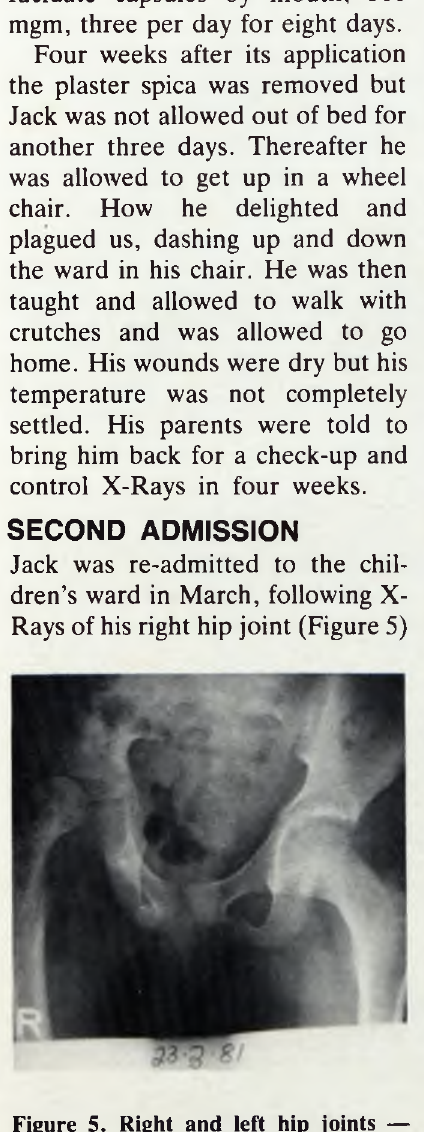
Figure 5. Right and left hip joints — right acetabulum partly destroyed and